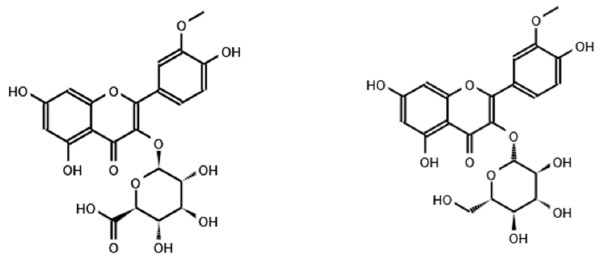
Figure 2. Chemical structure of isorhamnetin 3- O - D -glucuronide ( left ) and isorhamnetin 3- O - β -glucopyranoside ( right ).